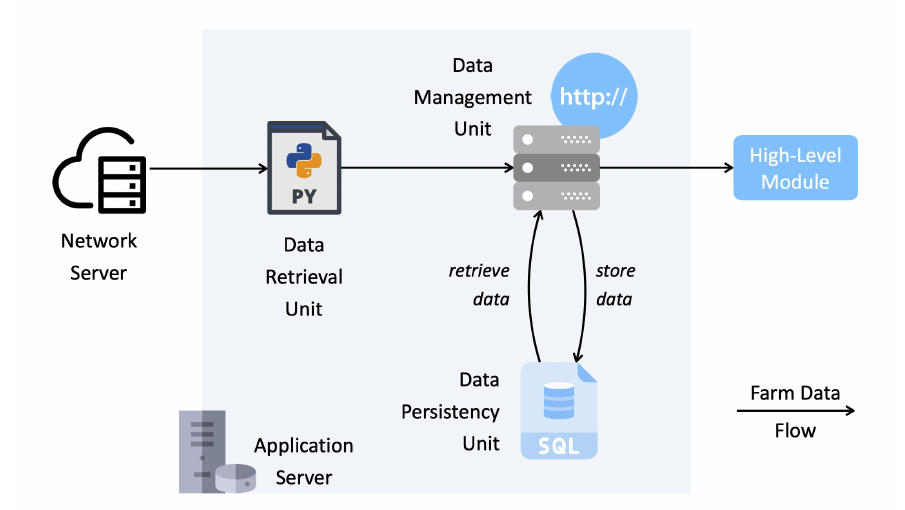
Figure 10. The LoRaFarM AS and the farm data flow between its